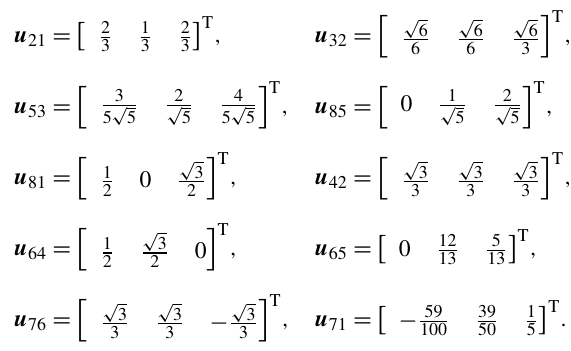
where the unit vectors associated with the primary instanta- neous axes of velocity are given